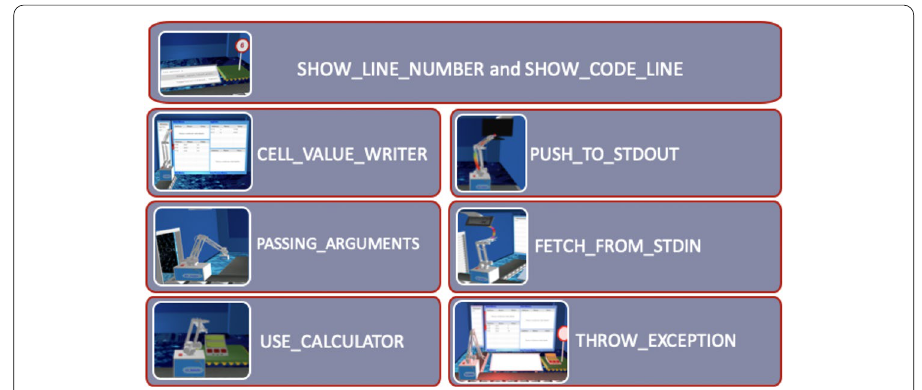
Fig. 3 Procedural programming Diogene-CT